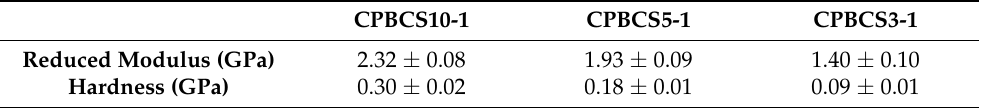
Table 4. Hardness and modulus of